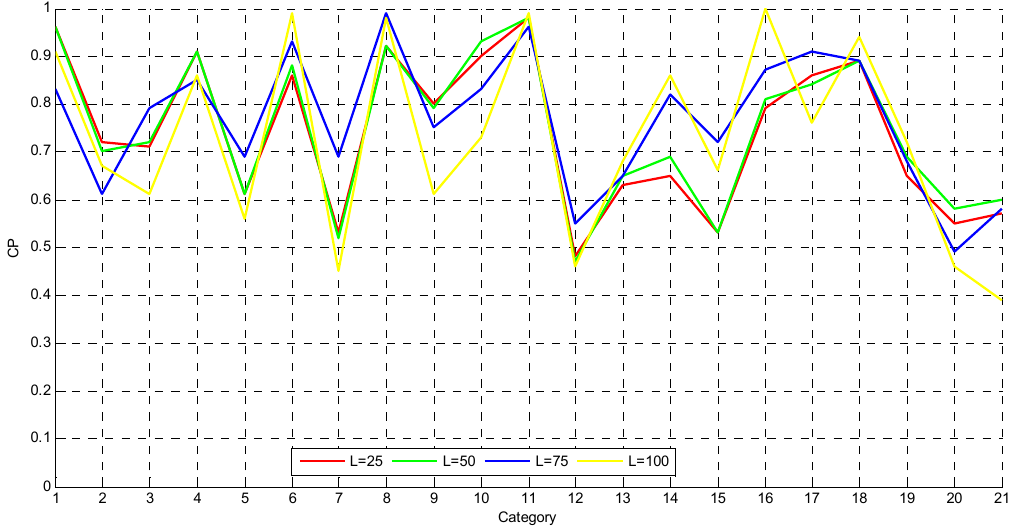
Figure 7. Class-level precision (CP) under different numbers of nearest neighbor nodes.